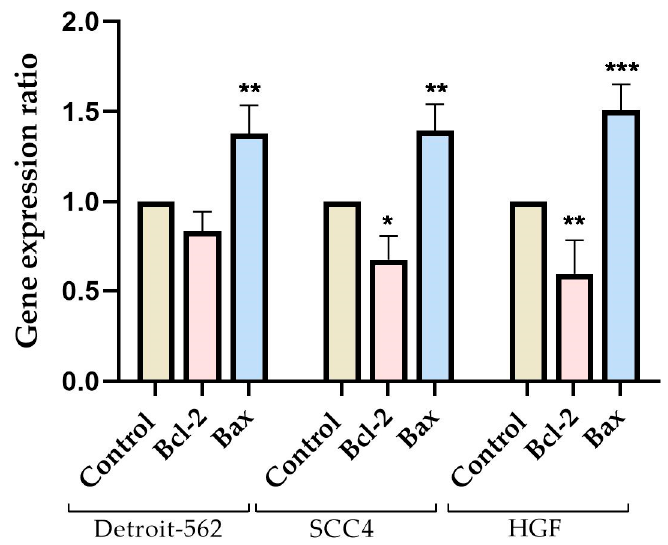
Figure 10. Relative fold-change expression of mRNA of pro-apoptotic (Bax) and anti-apoptotic (Bcl-2) markers in Detroit-562, SCC4, and HGF cells immediately after UVB (5 J/cm 2 ) exposure. The mRNA expression levels were normalized to 18 S expression, and the mean values ± SD of the three independent experiments were presented based on a one-way ANOVA analysis with Dunnett’s post hoc test, which were used to identify the statistical differences (* p < 0.05; ** p < 0.01 and *** p < 0.001).